Question: Provide a one-line summary of what is displayed.
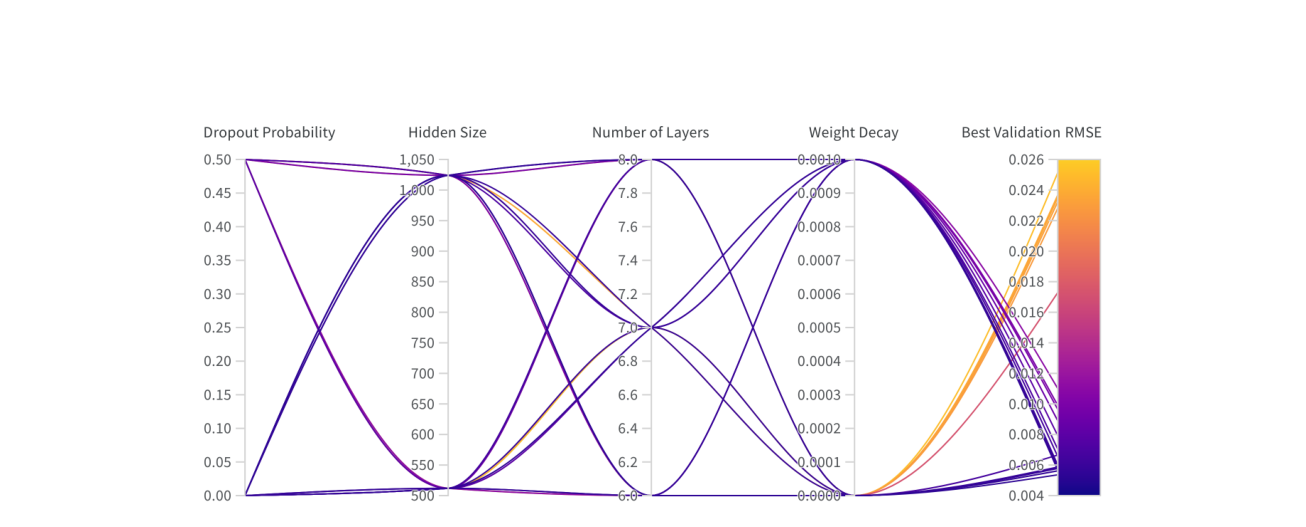
Answer: Hyperparameter grid search mapped to the best validation loss for DS1. Each column represents a variable in the hyperparameter space that has more than one available value. Sweeps are traversing these columns from the left hand side to the right hand side, mapping their hyperparameters to their best validation loss as root mean squared error. The color map indicates the magnitude of the loss relative to the minimum and maximum loss values of all sweeps. Plot generated via Weights and Biases [17].